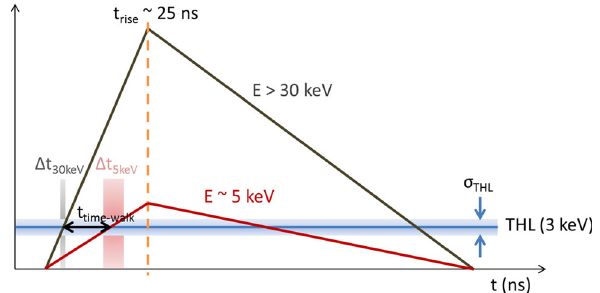
Fig. 2 Illustration of the time-walk effect: a low energy signal, occur- ring in the same time as a higher energy signal is assigned to a later time stamp